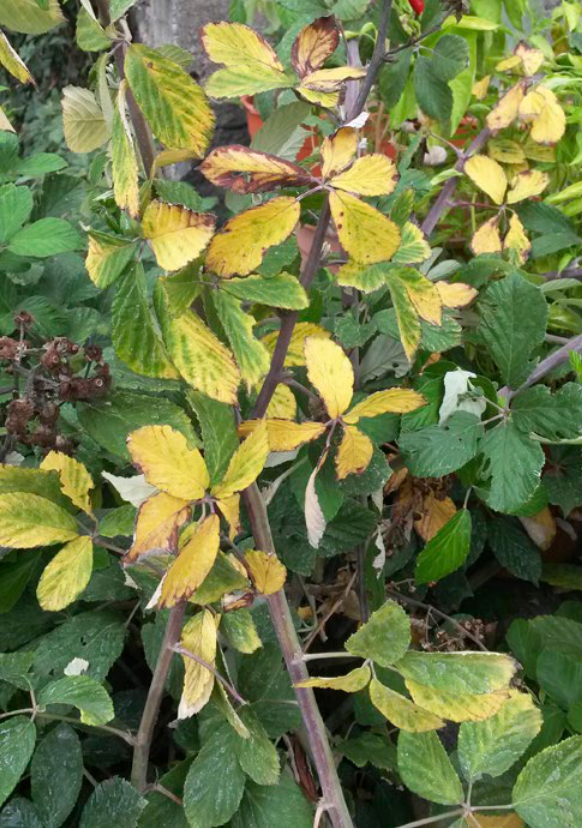
Figure 2. Diseased foliage on a thornless blackberry plant affected by Neofusicoccum parvum , grown in southern